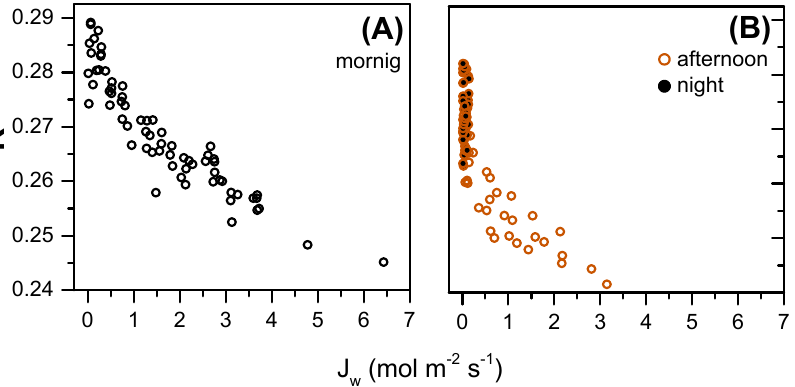
Figure 5. Correlation between R and Jw over a time series (8 consecutive days) recorded in tree #5 during the ( A ) “morning” and ( B ) “afternoon” and “night” stages. The “morning” stage begin early when transpiration start (approx. 6:00 h) and end at time n (approx. 13–15 h), when the difference between transpiration measured at time n + 1 and that measured at time n is <0. The “afternoon–night” span from hour n + 1 till the 4:00–5:00 h of the next day before the beginning of the new transpiration cycle.